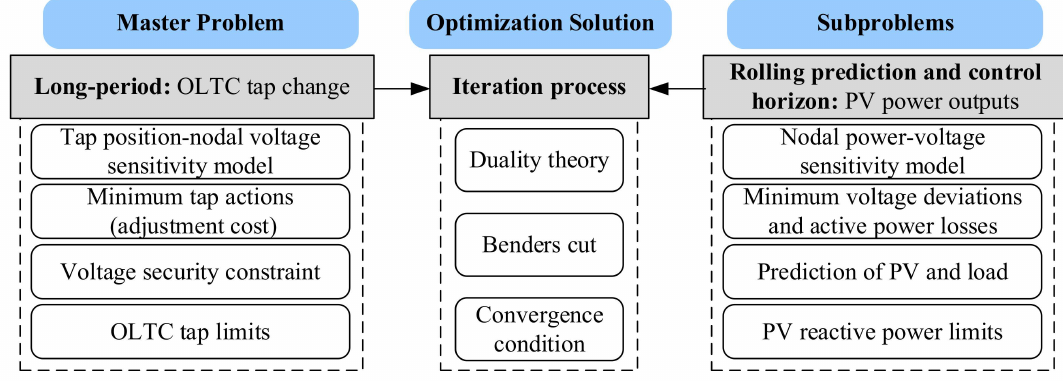
Figure 2. The detailed decomposition diagram of DRM